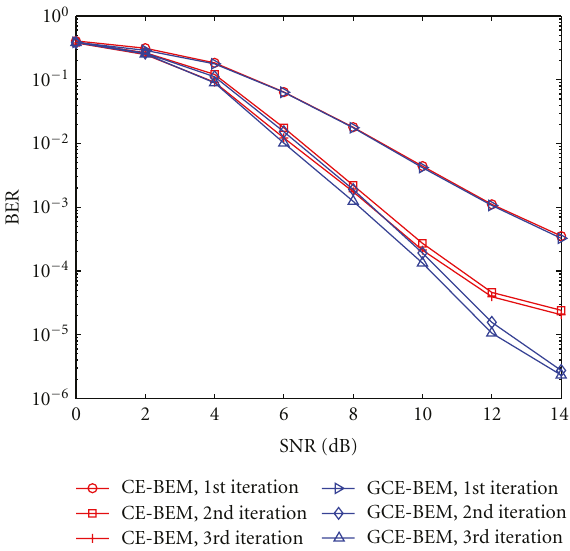
Figure 4: BER performance comparison of di ff erent basis functions for OFDM